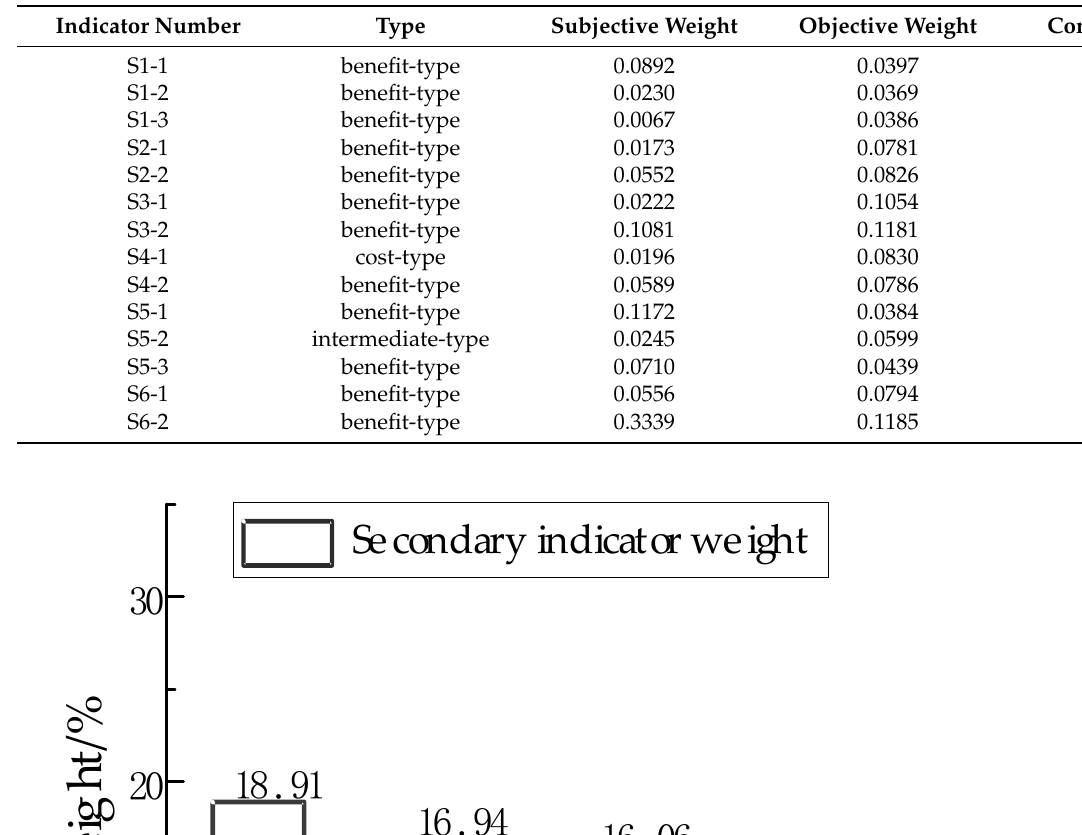
Table 5. Calculation results of three-level indicator weights.